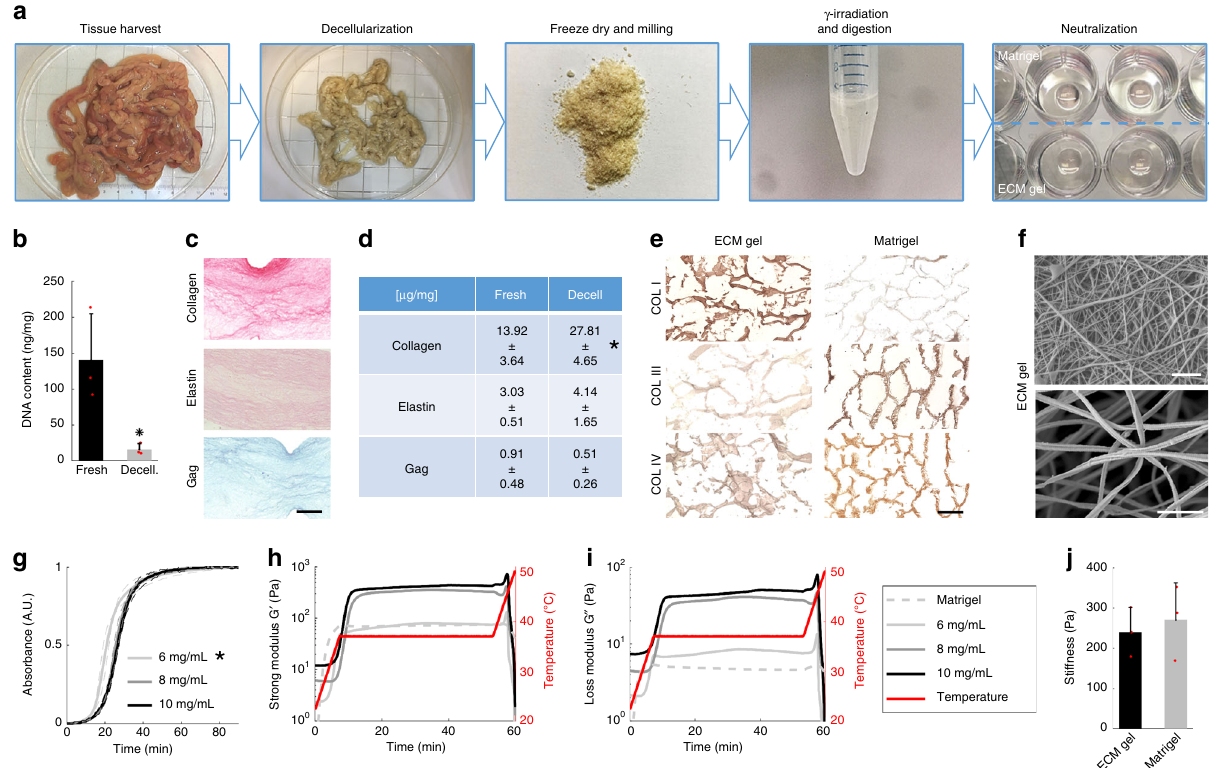
Fig. 1 Extracellular matrix hydrogel characterization. a The gelation preparation protocol consists of decellularization of the SI mucosa/submucosa, freeze-drying process, milling into a fi ne powder, gamma-irradiating and digesting the powder in pepsin and HCl for 72 h, and neutralization to a physiological pH, salinity and temperature. b DNA quanti fi cation in fresh (immediately after organ harvest) and decellularized piglet mucosa. Mean± S.D. ( n = 3 small intestines). Two-sided t -test * P < 0.05. Asterisk denotes signi fi cance. Red dots show individual data points. c Histological sections of fi xed ECM gel drops stained with Picrosirius Red, Verhoeff ’ s and Alcian Blue for collagen, elastin and glycosaminoglycans, respectively. Scale bar 200 μ m. d Quanti fi cation of ECM proteins: collagen, elastin and GAG. Mean ± S.D. ( n = 3 gel batches). Two-sided t -test * P < 0.05. e Analysis of the collagen types in ECM gel and Matrigel by staining for collagen I, III, and IV. Scale bar 100 μ m. f Scanning electron microscopy (SEM) images of the ECM gel displaying the interconnected fi brous network. Scale bars 1 µ m. g Spectrophotometry used to assess the turbidity of the samples during gelation. Mean± S.D. ( n = 2 gel batches). Two-sided t -test * P < 0.05 of T lag . h , i Oscillatory rheology provides a rheological pro fi le of various concentrations of the ECM gel and Matrigel, for both h storage modulus and i loss modulus. j Elastic modulus measured by nanoindentation of 6 mg/mL ECM gel vs. Matrigel in 30 µ L drops. Mean± S.D. ( n = 3 gel droplets). Two-sided t -test * P <